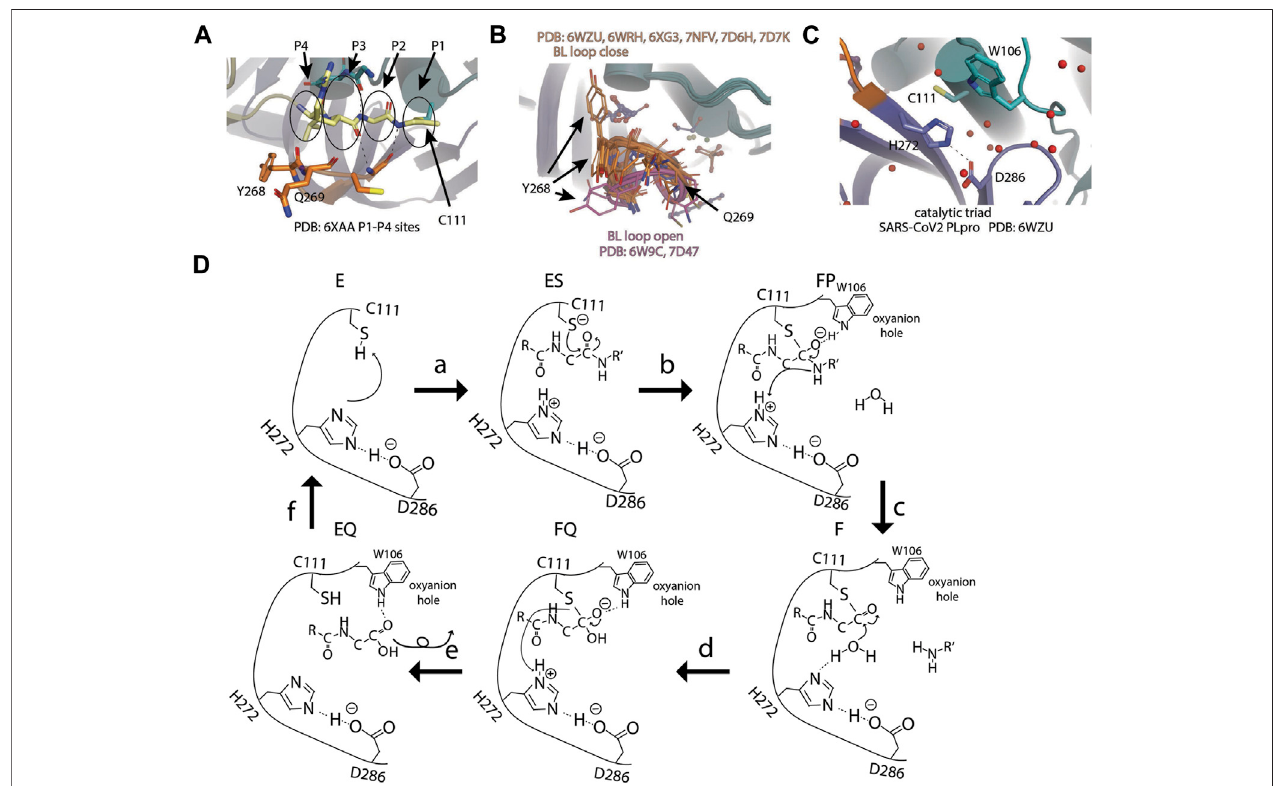
FIGURE 3 | Active site and catalysis. (A) Close-up view of catalytic pocket PLpro with Ub bound. The last four residues of Ub occupy P1 – P4 sites of the substrate binding pocket: P1 by G76, P2 by G75, P3 by R74, and P4 by L73. P1 – P4 sites are highlighted by circles. (B) Apo structures of SARS-CoV-2 PLpro are superimposed and shown as cartoon (PDB open: 6W9C and 7D47; close: 6WZU, 6WRH, 6XG3, 7NFV, 7D6H, and 7D7K). Side chains of residue Y268 and Q269 are shown as thin sticks. BL loops in open conformation are colored pink and closed. Conformations are colored orange. (C) Close-up view of catalytic triad of SARS-CoV-2 PLpro (PDB 6WZU). (D) Schematic drawing ofcatalytic cycleofSARS-CoV-2PLpro. Inunliganded “ E ” state, theimidazolegroup ofH272 attacks C111 thiolgrouptolowerits pKa.Inthe “ ES ” state, when substrate enterstheactive site,thiolateattacks thecarbon atomofamide bondand formsthe fi rsttetrahedralintermediate( “ FP ” state).The negative charge is transferred to amide oxygen and is stabilized by the oxyanion hole. The amine product is release upon breakage of peptide bond ( “ F ” state). A water moleculeattacksthecarbonylandformsthesecondtetrahedralintermediate( “ FQ ” state).Lastly,theeliminationofcysteinefromtheintermediatefreestheN-terminusof the substrate ( “ EQ ” state) and the enzyme is restored to the “ E ”